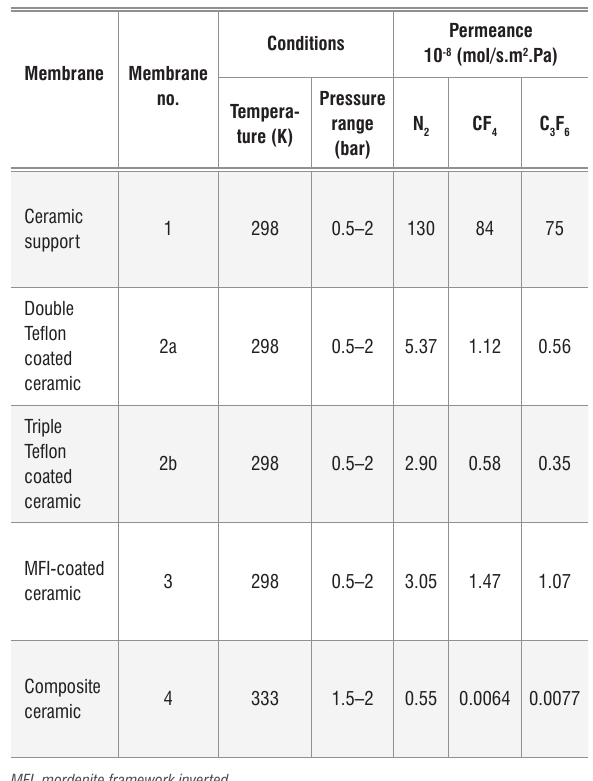
Figure 10: Permselectivity of N support, (2a) double Teflon coated ceramic, (2b) triple Teflon coated ceramic, (3) mordenite framework inverted (MFI)-coated ceramic and (4) composite ceramic membranes. The respective Knudsen selectivity values are indicated by the horizontal lines.